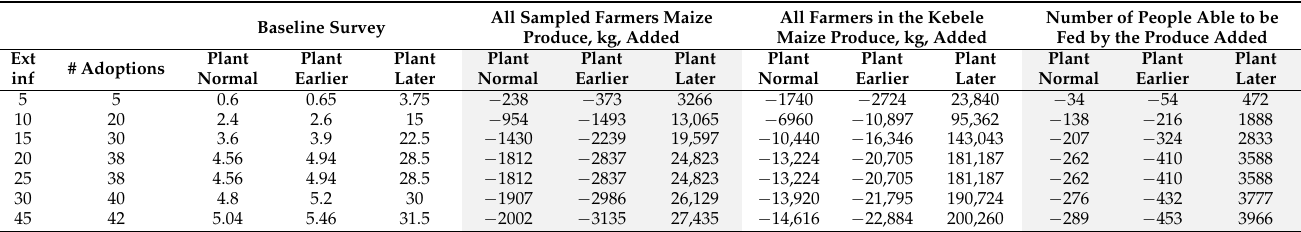
Table A8. Adoption rate of farmers’ interactions with agriculture extension workers, crop productivi- ties of adopted numbers, and number of people can be fed under less rain